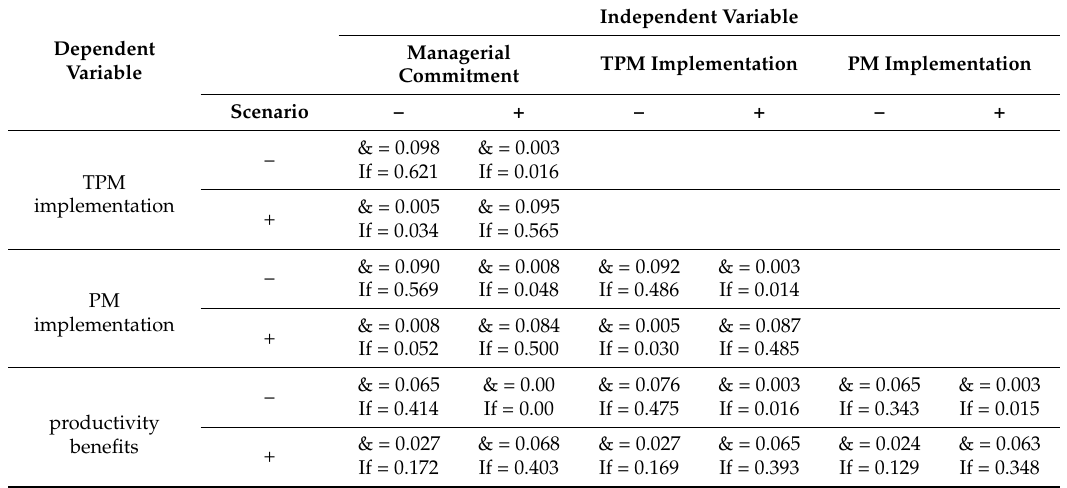
Table 10. Scenarios and probabilities for independent